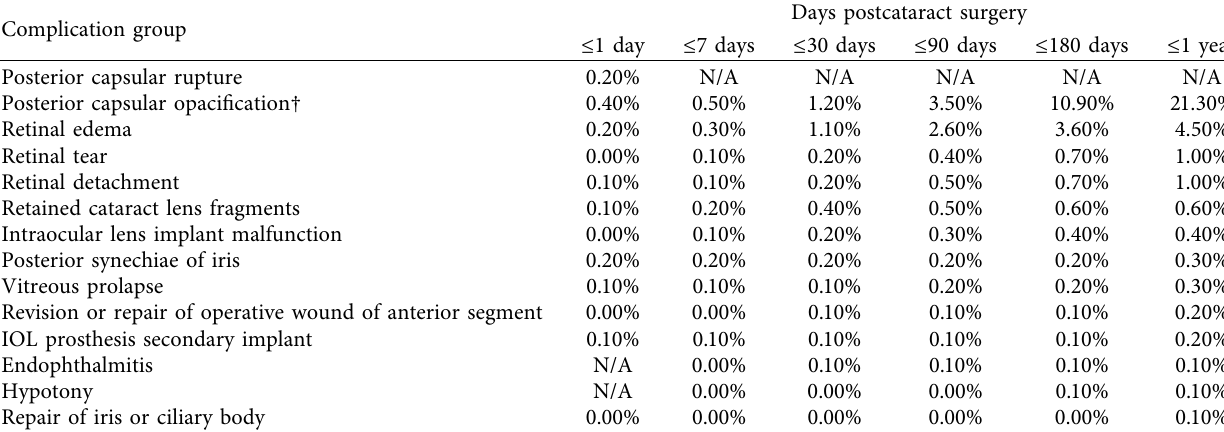
Table 4: Incidence of secondary surgical interventions postcataract surgery in the Medicare fee-for-service population IOLs. Follow-up time-point ≤ 6